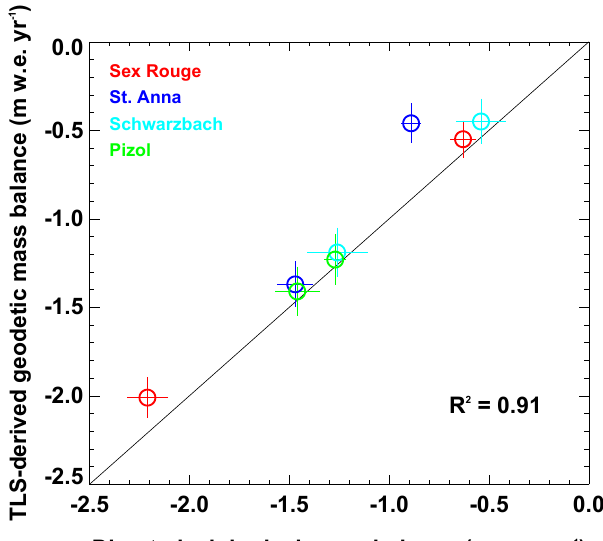
Figure 5. Direct glaciological vs. TLS-derived glacier-wide mass balances for Glacier du Sex Rouge, St. Annafirn, Schwarzbachfirn, and Pizolgletscher for the years 2013/14–2014/15. Error bars indi- cate the uncertainty ranges of both methods.